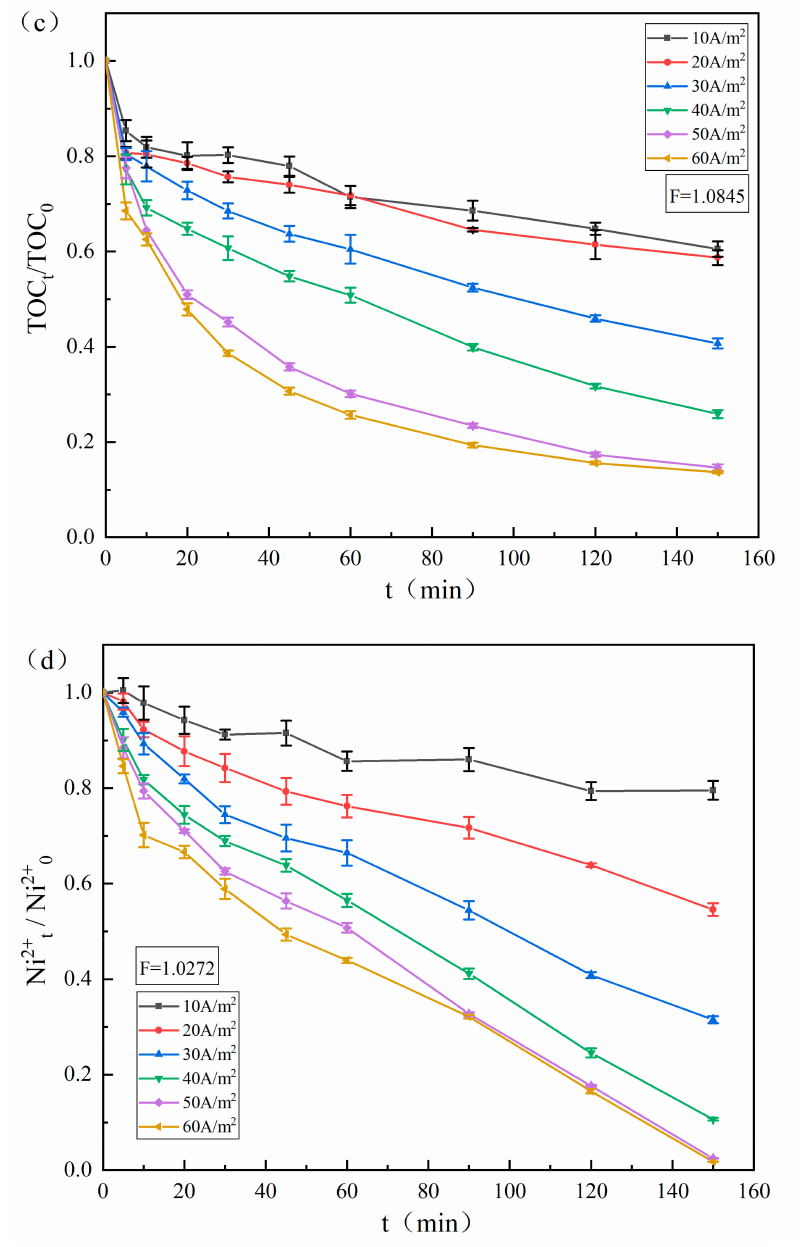
Figure 1. Evolution of COD Cr ( a ), ICE ( b ), TOC ( c ), and Ni 2+ ( d ) as a function of time at different cur- rent densities. Electrolysis conditions: electroplating sludge leaching solution (180 mL), temperature 25 ◦ C and pH